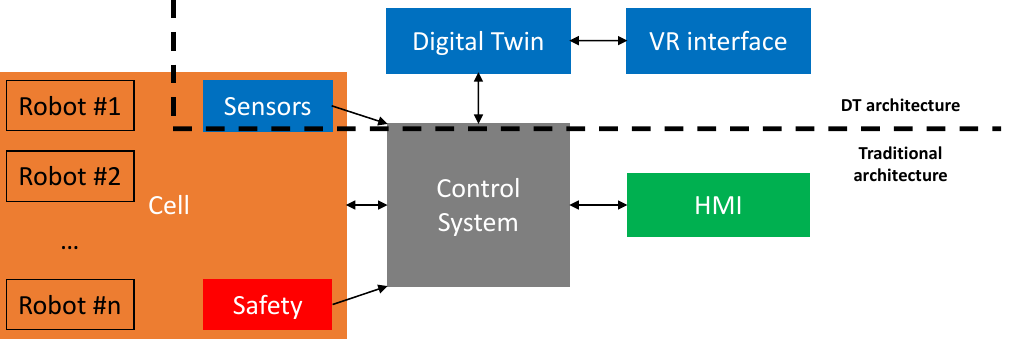
Figure 2. System architecture with the seven